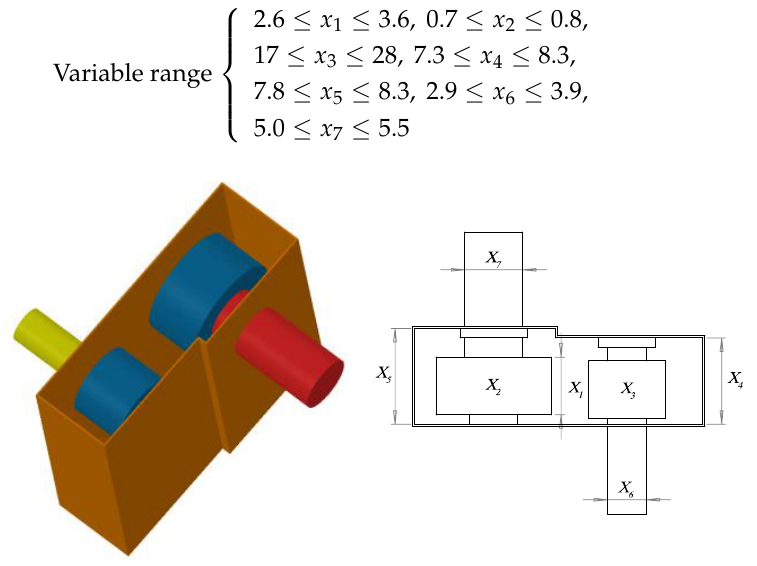
Figure 12. Speed reducer problem.